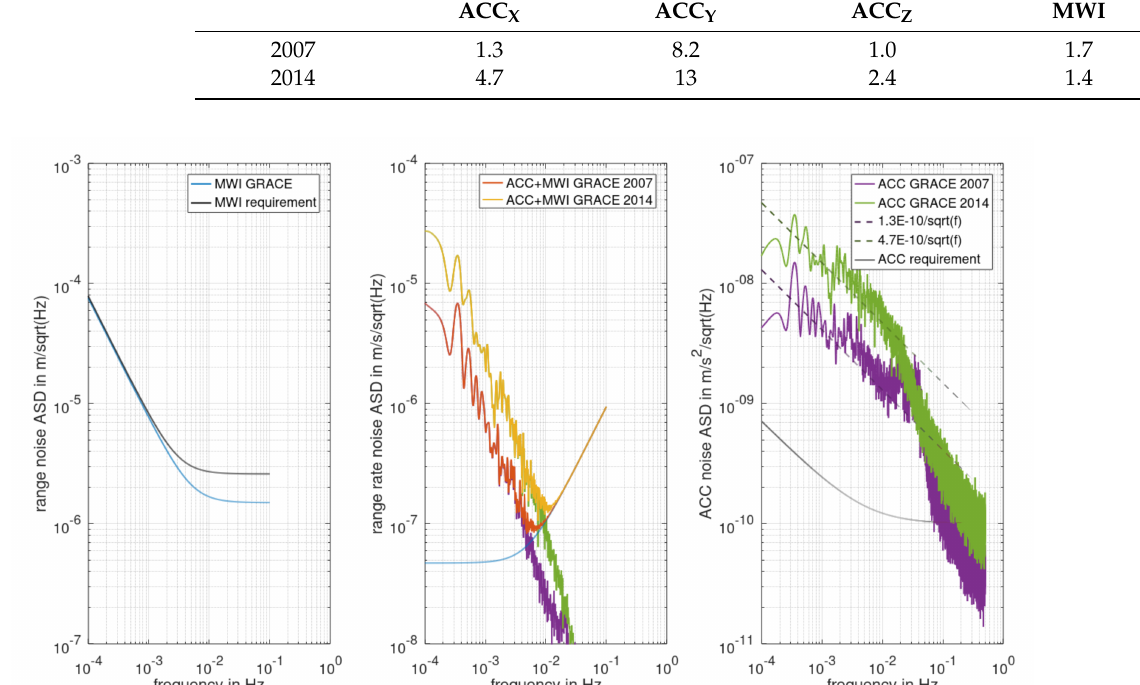
Figure 6. Noise models in terms of ASDs of the key GRACE instruments. ( Left ) GRACE MWI (blue) noise model and requirements in terms of range ASDs in m/ ACC noise models for 2007 (purple) and 2014 (green) with requirements in terms of acceleration √ ASDs in m/s 2 / Hz. ( Center ) combined GRACE ACC+MWI noise models in terms of range rate √ ASDs in m/s/ Hz (cf. Equation